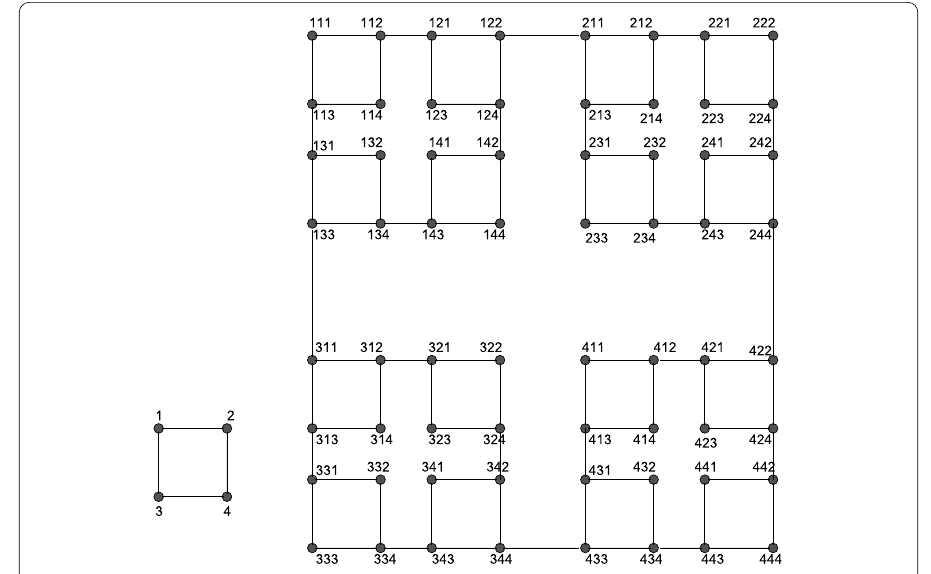
Figure 1 Generalized Sierpi´nski Graphs S (1, C 4 ) and S (3, C 4 )